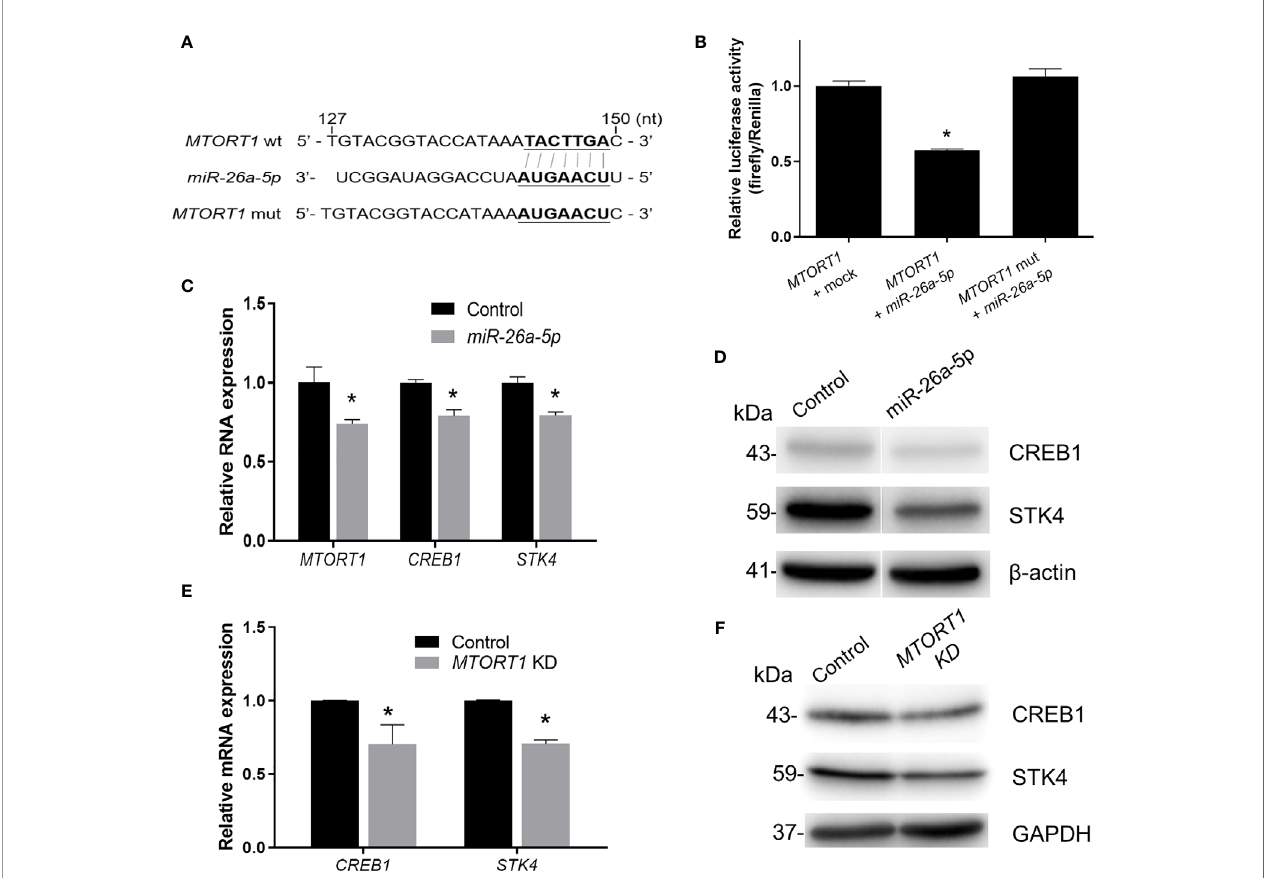
FIGURE 6 | MTORT1 up-regulates CREB1 and STK4 by directly interacting with miR-26a-5p . (A) Schematic diagram of the 3 ’ UTR of fi re fl y luciferase constructs showing the sequence of MTORT1 and the mutation of the miR-26a-5p binding site. The putative binding sequence was predicted by miRDB (26). wt, wild-type; mut, mutation. (B) Luciferase reporter assays in HEK-293T cells overexpressing miR-26a-5p . HEK293T cells were co-transfected with pMIR-REPORT- MTORT1 or its mutant (pMIR-REPORT- MTORT1 mutant), miR-26a-5p mimics, and Renilla luciferase plasmid (pGL4.74 [hRluc/TK]). Activity of fi re fl y luciferase was normalized to the activity of Renilla luciferase. (C) Relative expression levels of MTORT1 in HEK293T cells overexpressing miR-26a-5p were measured by quantitative RT-PCR and normalized to 18S rRNA. Relative expression levels of miR-26a-5p downstream genes CREB1 and STK4 are also shown. (D) Western blotting of CREB1 and STK4 in HEK293T cells overexpressing miR-26a-5p . b -actin: loading control. (E) Relative expression levels of miR-26a-5p downstream genes, CREB1 and STK4 , in MCF- 7 cells treated with siRNA against MTORT1 . The results are means ± SDs (n = 3). * P < 0.05. (F) Western blotting of CREB1 and STK4 in MCF-7 cells treated with siRNA against MTORT1 . GAPDH: loading